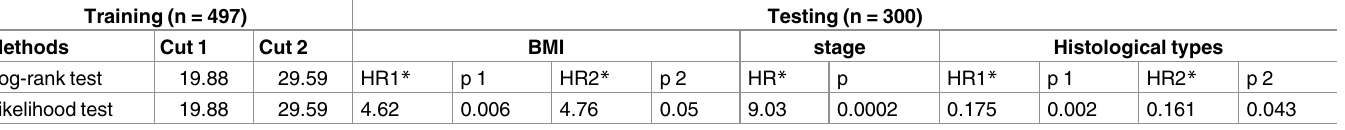
Table 4. Multiple cutoff points: Body mass index (BMI) vs.